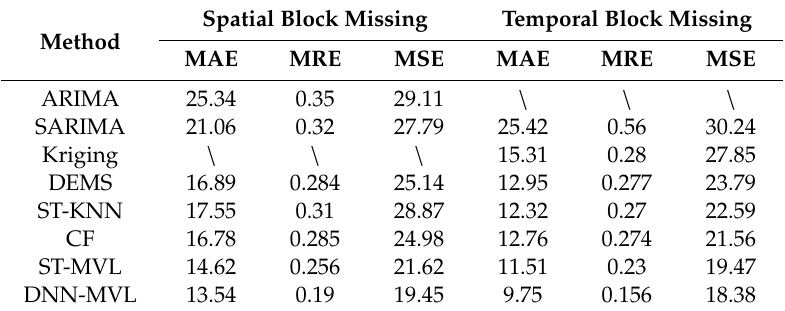
Table 3. Comparison among different methods (based on dam deformation data).